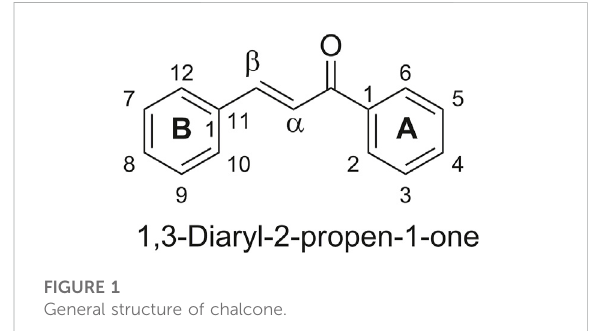
FIGURE 1 General structure of